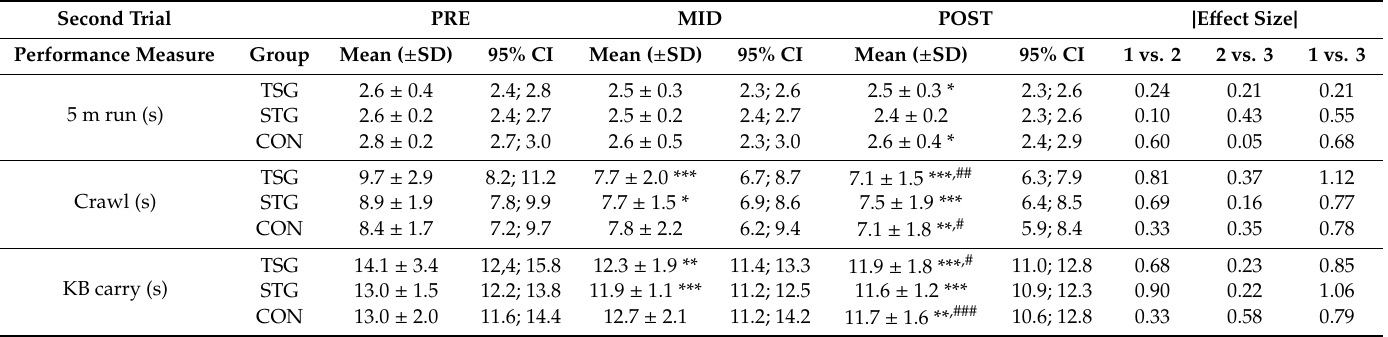
Table 4. Simulated military task performance times for di ff erent tasks (first 5 m run, crawl, kettlebell carry (KB), casualty drag, and final 10 m run) from the second trial in the PRE, MID, and POST measurement